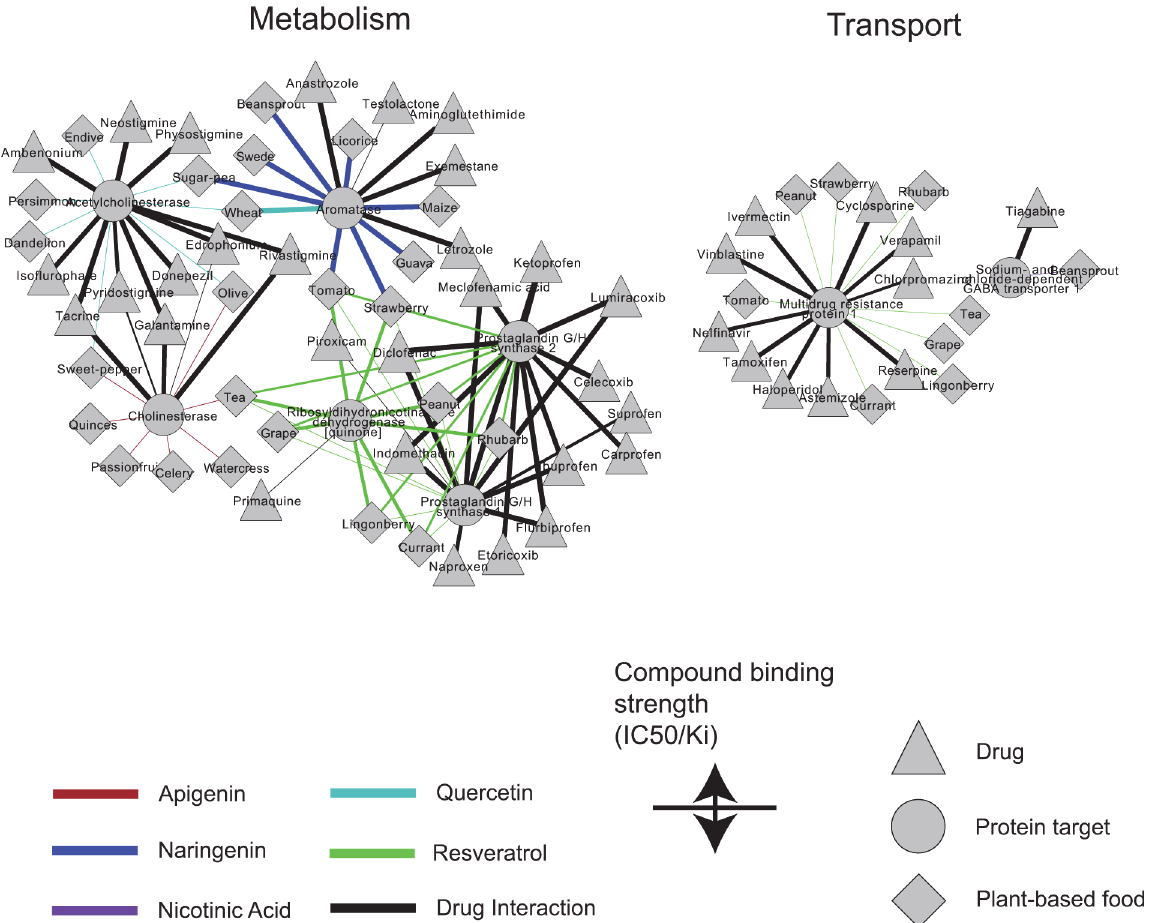
Fig 4. Networks of drug-food interactions affecting drug pharmacokinetics. Node shape denotes enzyme/transporter (circle), drug (triangle) and food (diamond). Edge color highlights the phytochemical with the highest binding activity to the protein target. Edge width denotes the biological activity (Ki, IC50) and ranges between 1nM to 1000 nM. For visualization purposes, only 3 drugs and 3 foods with the highest biological activities are shown for each protein target, while the complete data are provided as supplementary material (S4 Table).